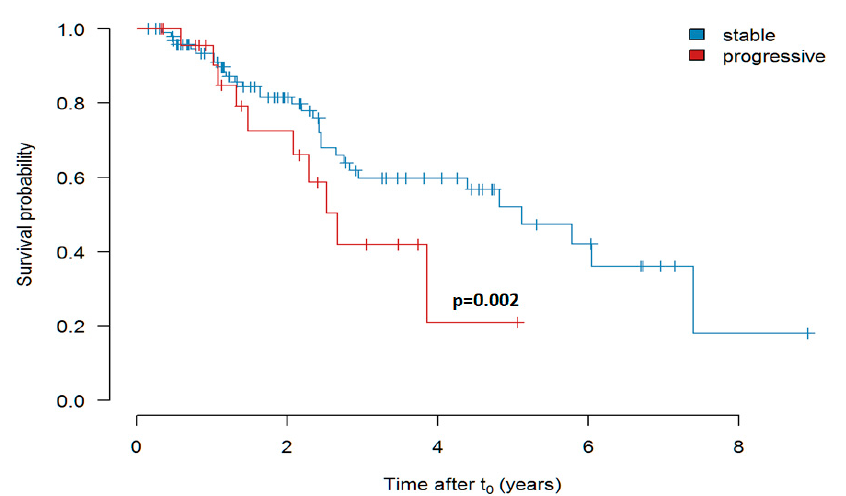
Figure 5. Survival of pirfenidone-treated patients with “stable” (FVC decline less than 10% p.a.) versus “progressive” (FVC decline more than 10% p.a.) disease prior to initiation of therapy (Kaplan-Meier curve shows estimate values). In this analysis the FVC slope was used as continuous predictor in a Cox proportional hazards (PH) model.